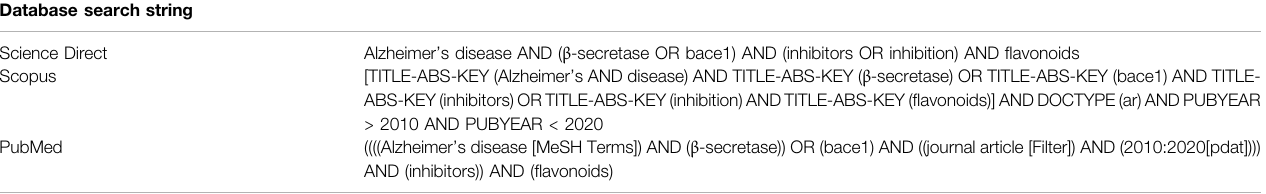
TABLE 2 | Inclusion and exclusion criteria used in the screening phase of the literature search. Inclusion criteria Evaluation of the BACE1 enzyme inhibition assay Studies involve fl avonoid compounds against the BACE1 enzyme Design of the study includes in vitro evaluation. If in silico studies were present, it must be supplemented with in vitro